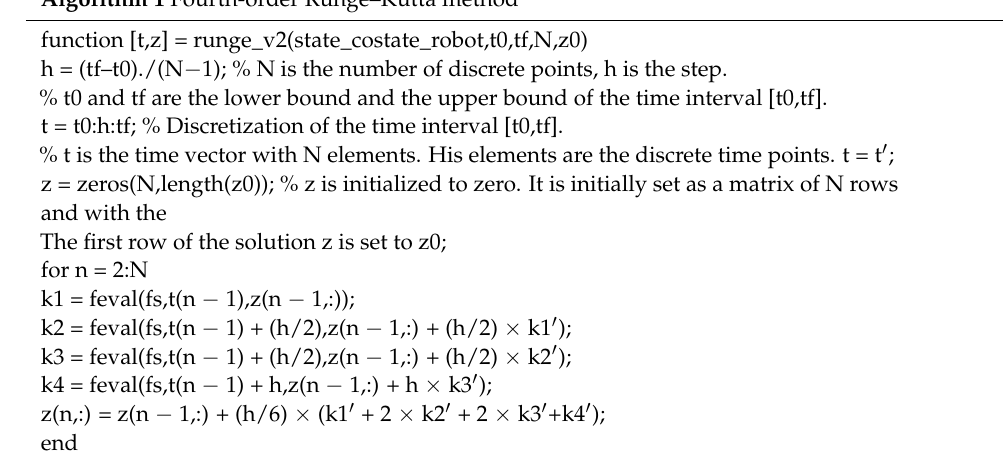
Algorithm 1 Fourth-order Runge–Kutta